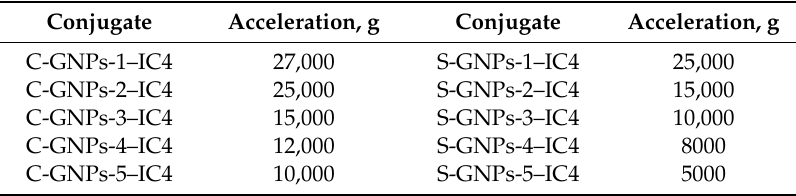
Table 3. Regimes for the separation of GNP-antibody conjugates. Conjugate Acceleration, g Conjugate Acceleration,